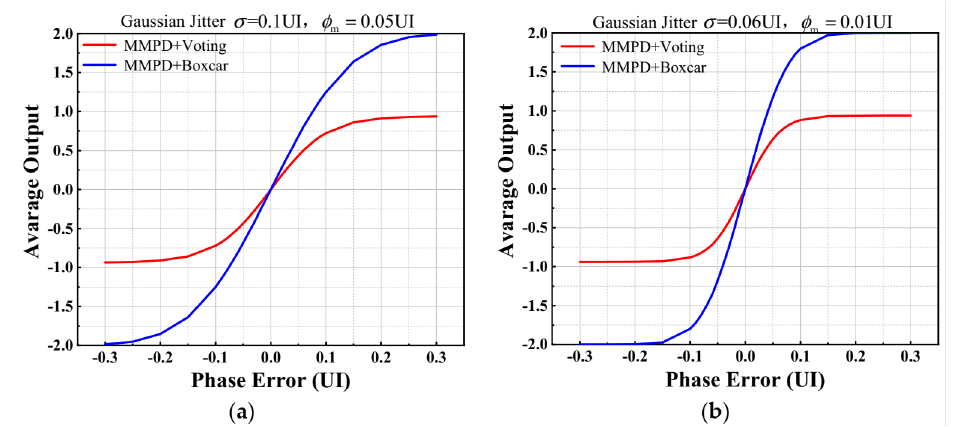
Figure 5. Simulated decimation by voting and boxcar, ( a ) σ = 0.1 UI, φ m = 0.05 UI, ( b ) σ = 0.06 UI, φ m = 0.01 UI.